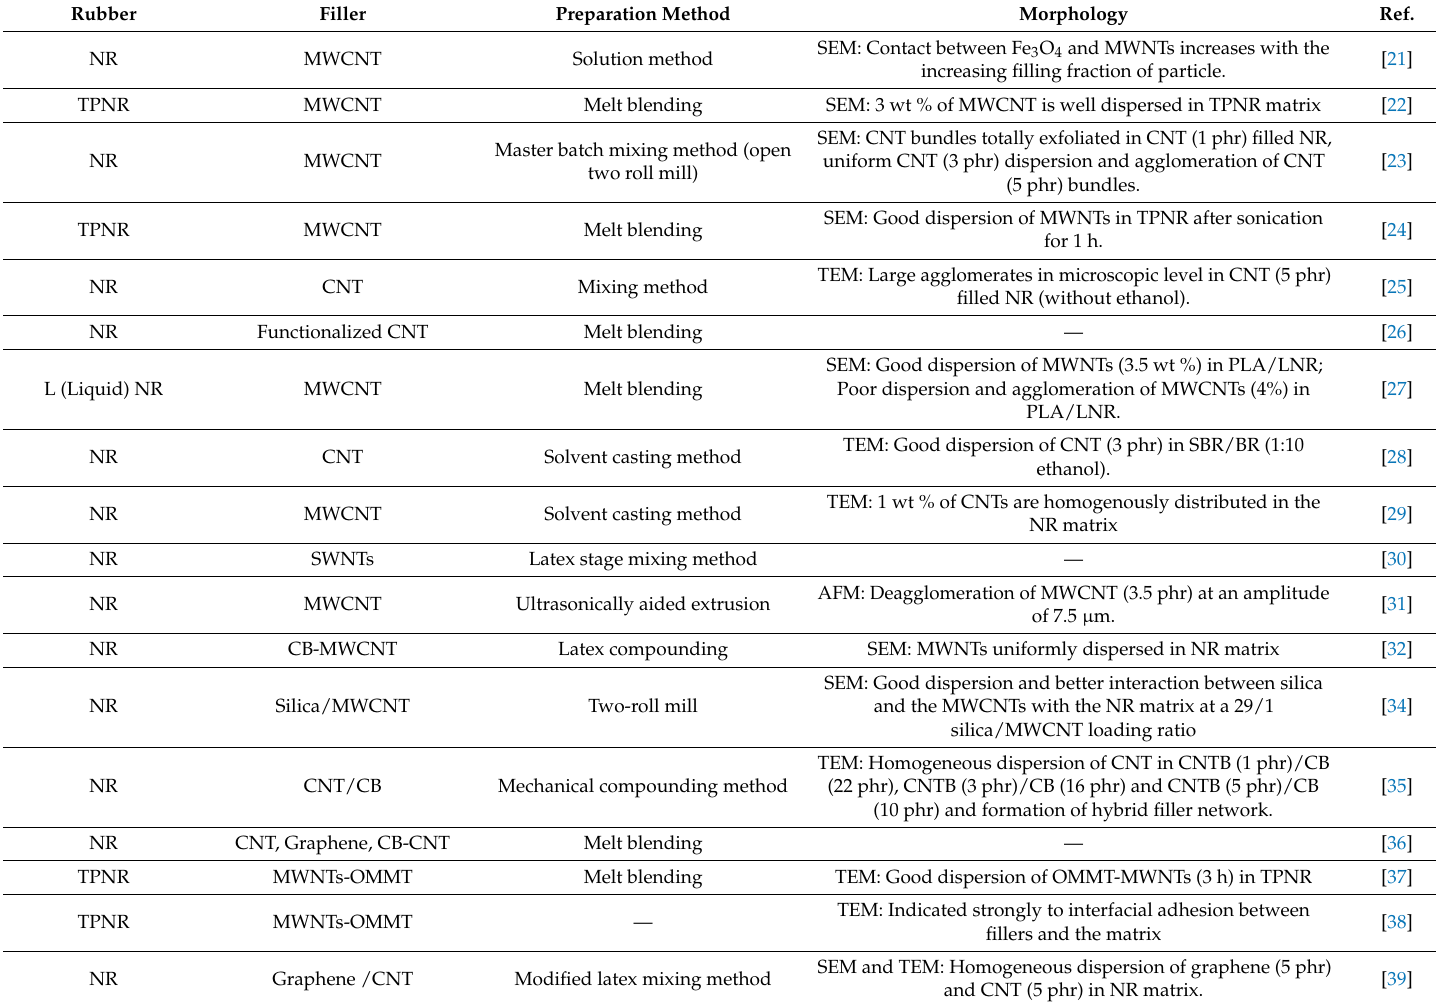
Table 1. Types of carbonaceous nanofillers, preparative methods adopted and morphology of natural rubber (NR)